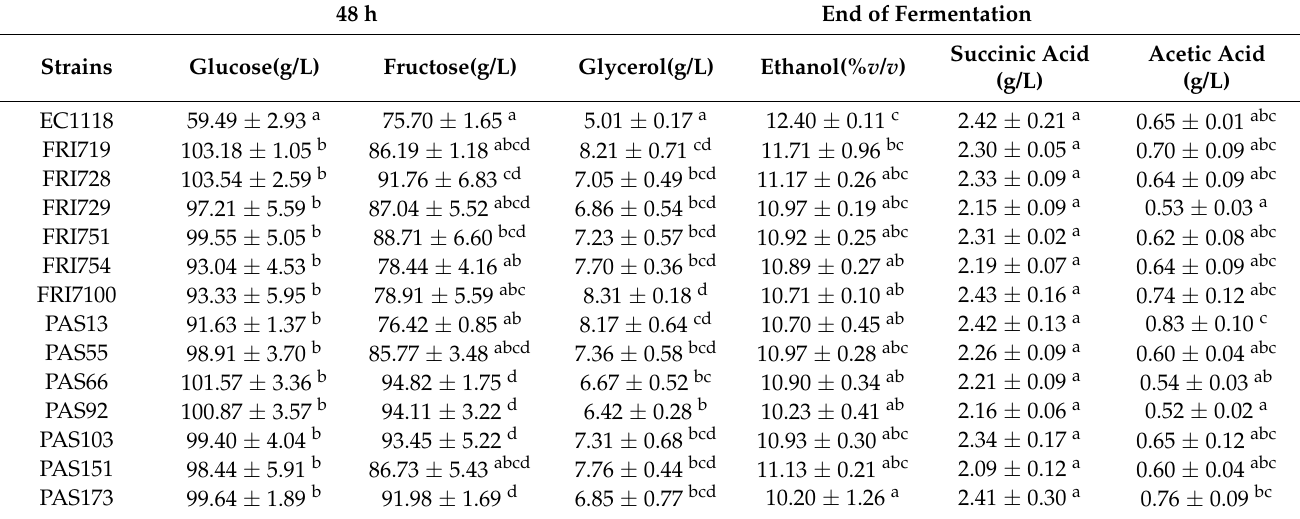
Values are represented by the average and standard deviation ( n = 3). The difference between the averages was analyzed by one-way ANOVA and Tukey post hoc tests. Different letters indicate significant statistical differences p < 0.05 (Tukey’s test). Table 3. Glucose and fructose residues at 48 h and concentrations of the main fermentation prod- ucts at the end of sequential fermentations with S. bacillaris strains and S. cerevisiae EC1118 in Manzoni bianco. End of